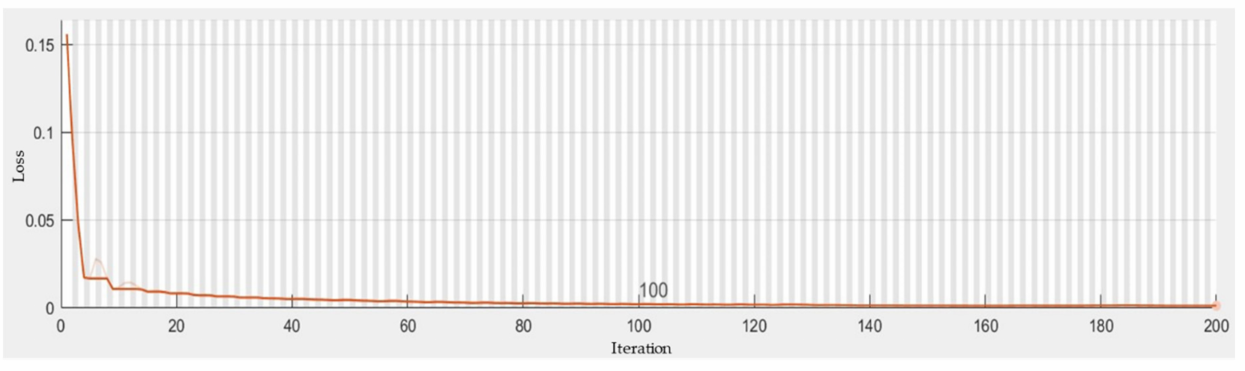
Figure 9. Comparison of the model-generated porosity and validated porosity.